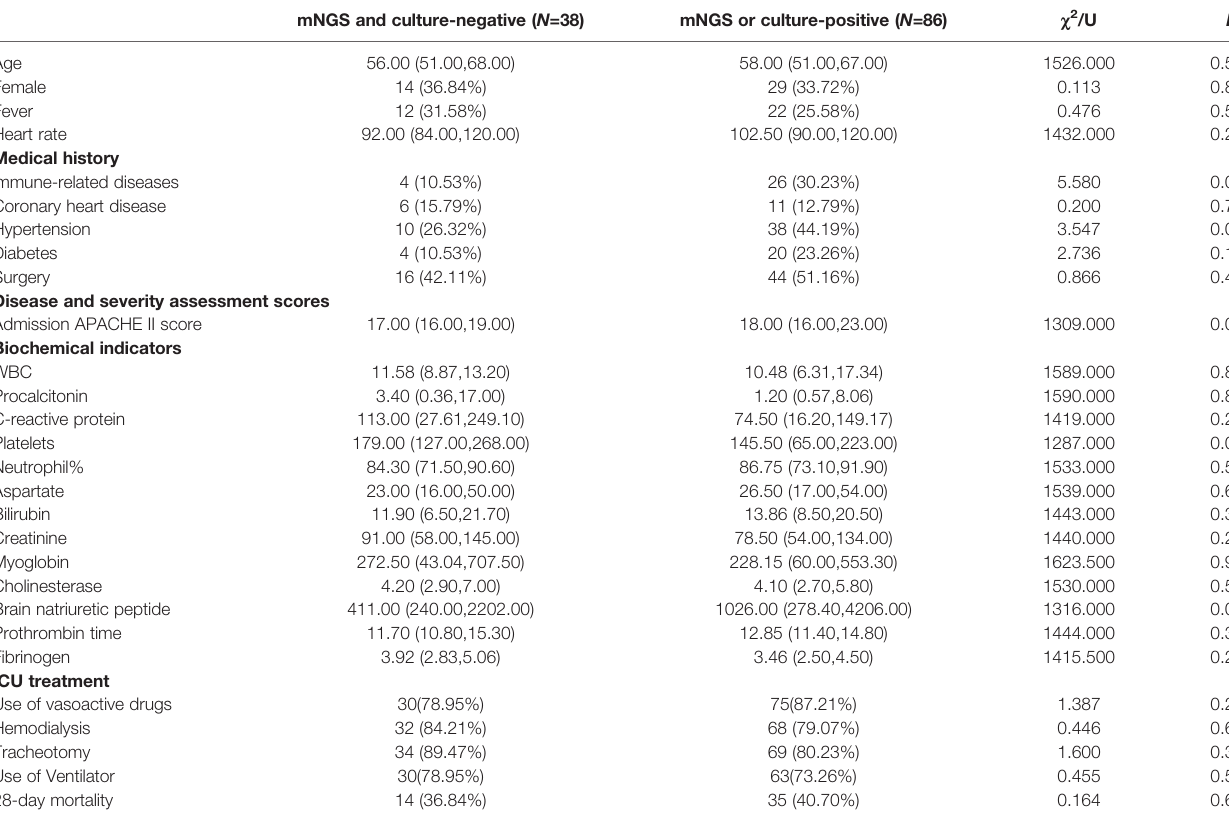
TABLE 3 | Comparison of clinical characteristics between mNGS and blood culture (positive and negative). mNGS and culture-negative ( N =38)